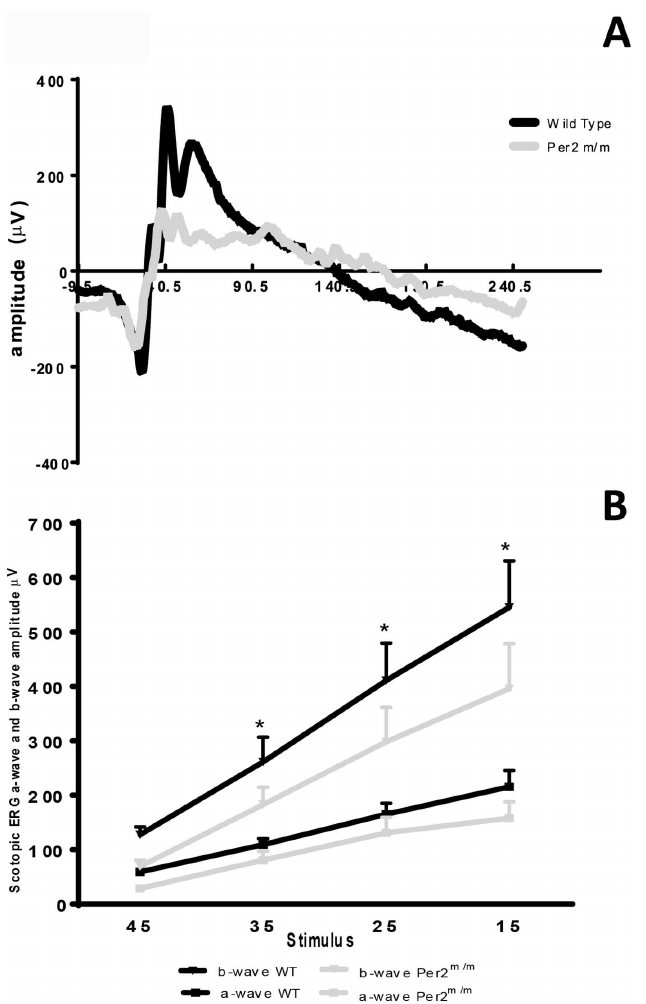
Fig 1. Per2 m/m mice exhibit decreased ERG amplitude. (A) Representative ERG trace for 15 db stimuli showinga decrease in ERG amplitudein Per2 m/m retinas (B) Line graph showinga similar decrease in